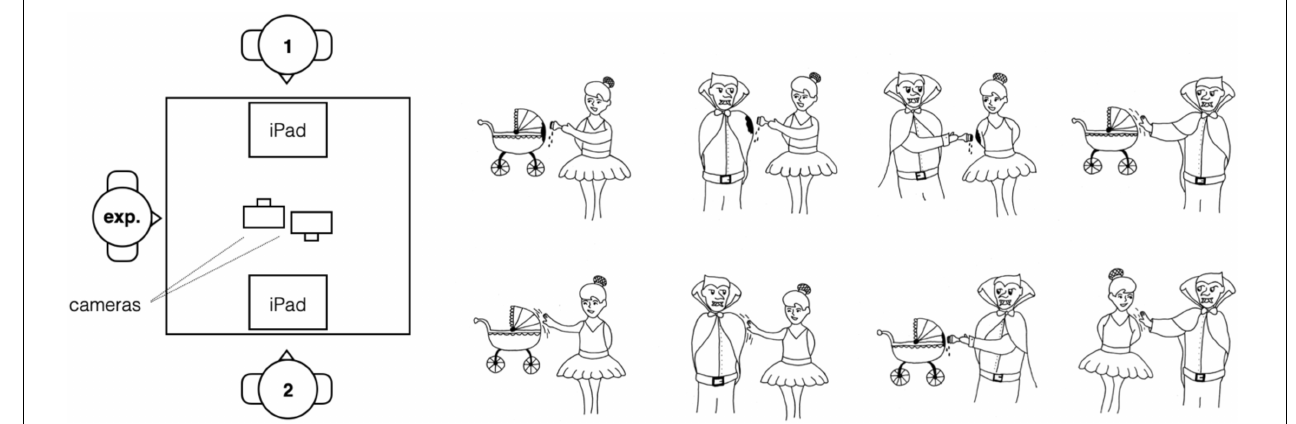
FIGURE 5 | Left: setup overview of Experiment 2. Right: example of stimuli screen with 8 events as shown to matcher.